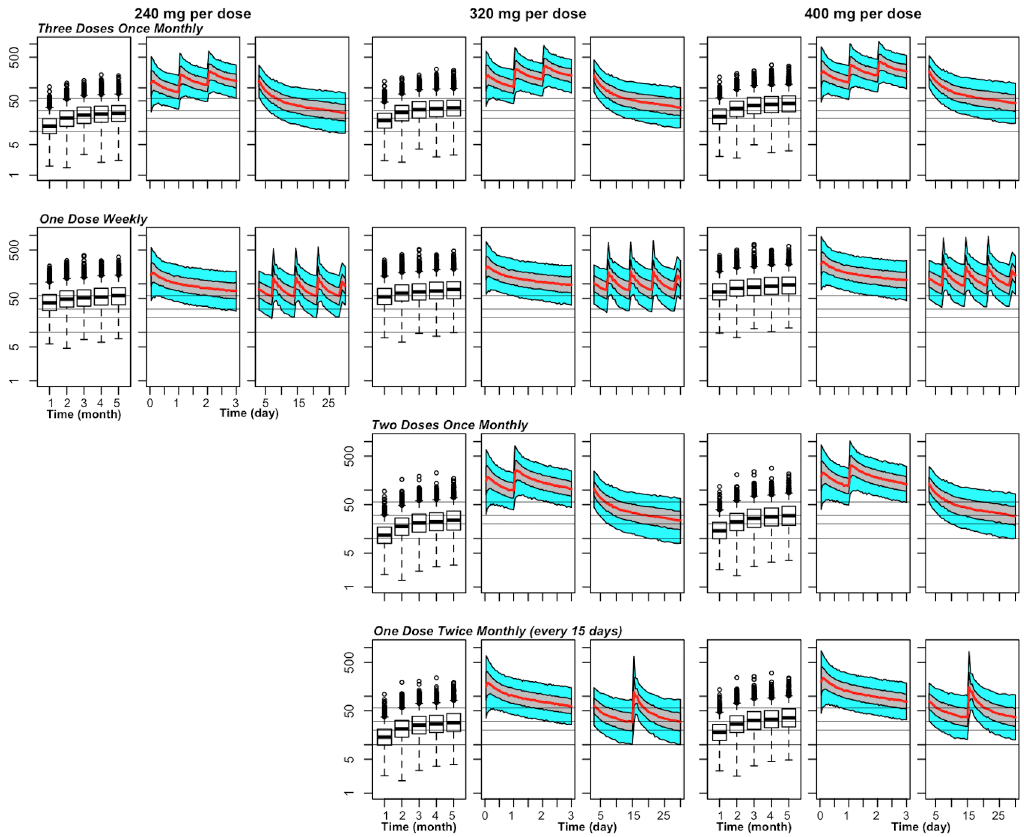
Fig 1. Predicted capillary plasma PQ concentration versus time for various chemoprevention regimens of DP in 1 – 2 year olds weighing (cid:4) 11 kg. For each combination of dose (240 mg, 320 mg, or 400 mg) and schedule (3 times once monthly, once weekly, 2 times once monthly or once every 15 days), there is a set of 3 panels, with the left panel (box plots) showing trough concentrations at the end of the first 5 months, the middle panel the steady-state PK profile during the first 3 days after the first dose of the month, and the right panel the steady-state PK profile during days 3 – 30 (or days 3 – 28 for weekly dosing) relative to a first dose of the month. For the PK profiles, the middle line represents the population predictions, the grey shaded area the 50% prediction interval and the outer bounds the 90% prediction interval. The grey horizontal lines indicate capillary plasma concentrations of 10, 20, and 30 ng/mL (for putative trough targets), and a capillary plasma level of 57 ng/mL (for a putative day 7 target).